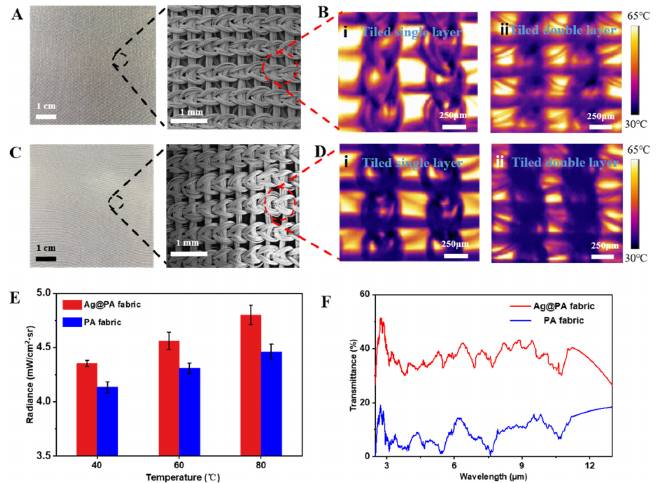
Figure 3. ( A , B ) Optical, SEM and IR thermal pictures of Ag@PA fabric; ( C , D ) optical, SEM and IR thermal pictures of PA fabric; ( E ) IR radiance energy of two fabrics at different heat sources; ( F ) IR transmission of two kinds of tiled fabrics.